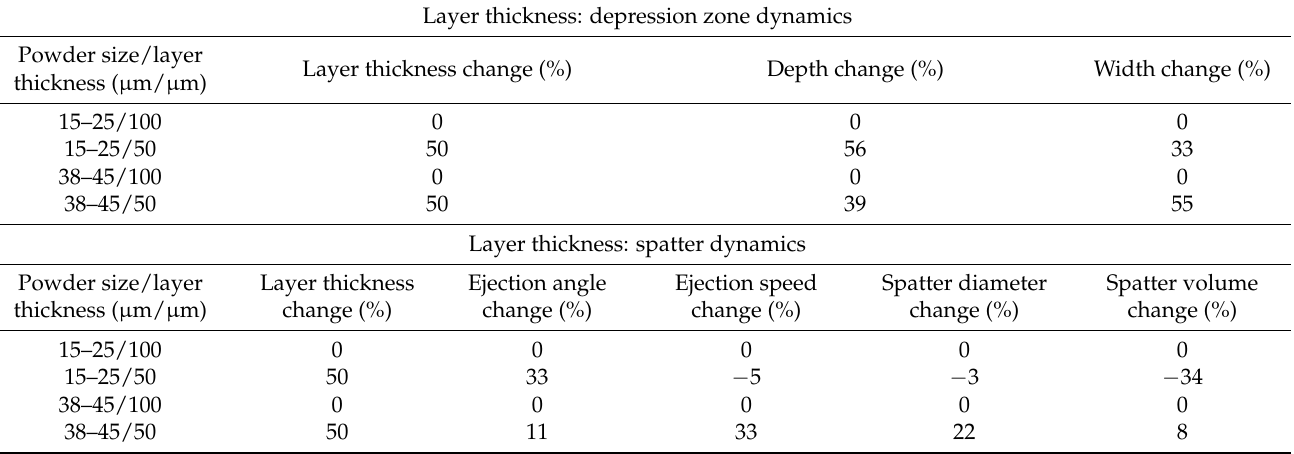
Table 6. Percent change in SLM dynamics induced by variations in the layer thickness. Layer thickness: depression zone